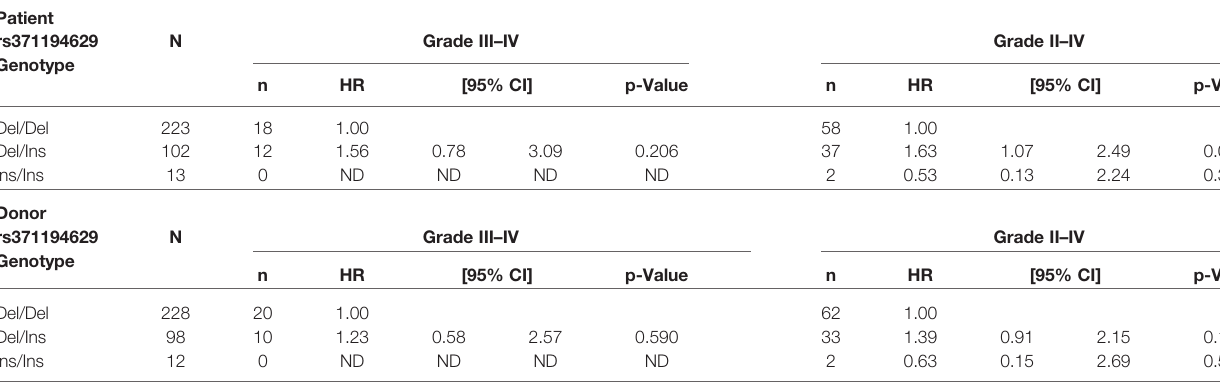
TABLE 7 | Association between the genotypes of HLA-G_Indels (rs371194629) and aGVHD. Patient rs371194629